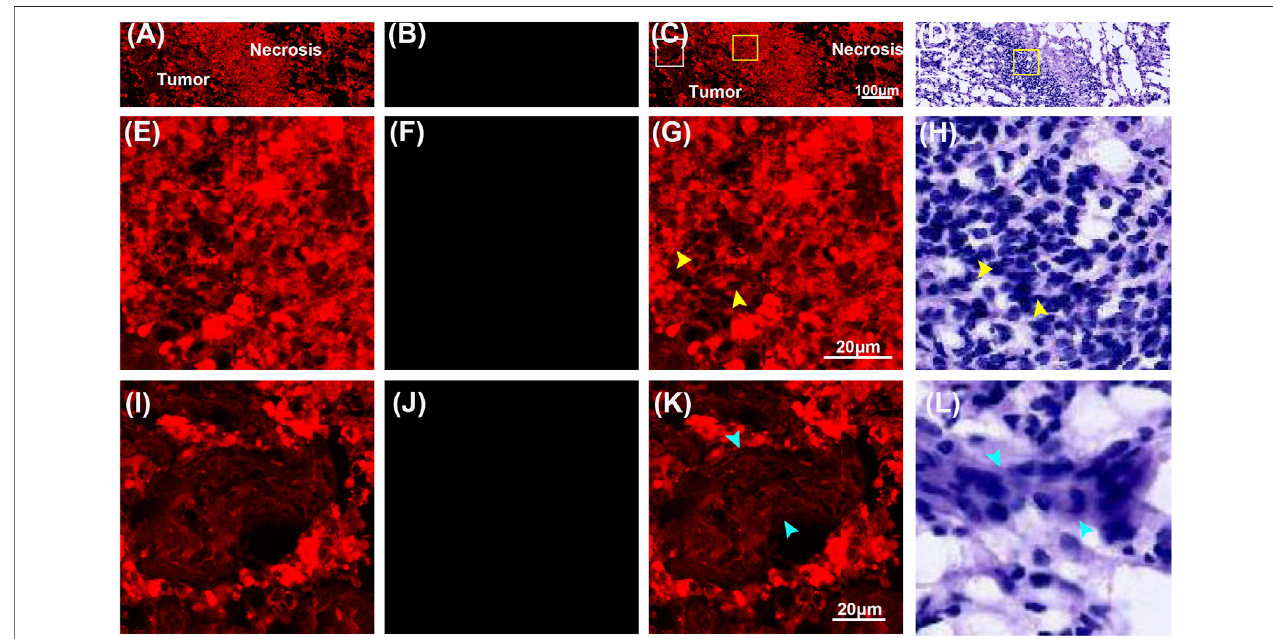
FIGURE 6| Representative MPM images and the corresponding images ofH&E stained high-gradeglioma (necrotic area). (A – D) TPEF, SHG, TPEF/SHG overlaid images, and the corresponding H&E image of high-grade glioma. (E – H) The magni fi ed TPEF, SHG, TPEF/SHG overlaid images, and corresponding H&E image of the selected area (white square box) in Figure 6C . (I – L) The magni fi ed TPEF, SHG, TPEF/SHG overlaid images, and corresponding H&E image of the selected area (yellow square box) in Figure 6C . Yellow arrowhead: tumor cells; cyan arrowheads: endothelial cells.